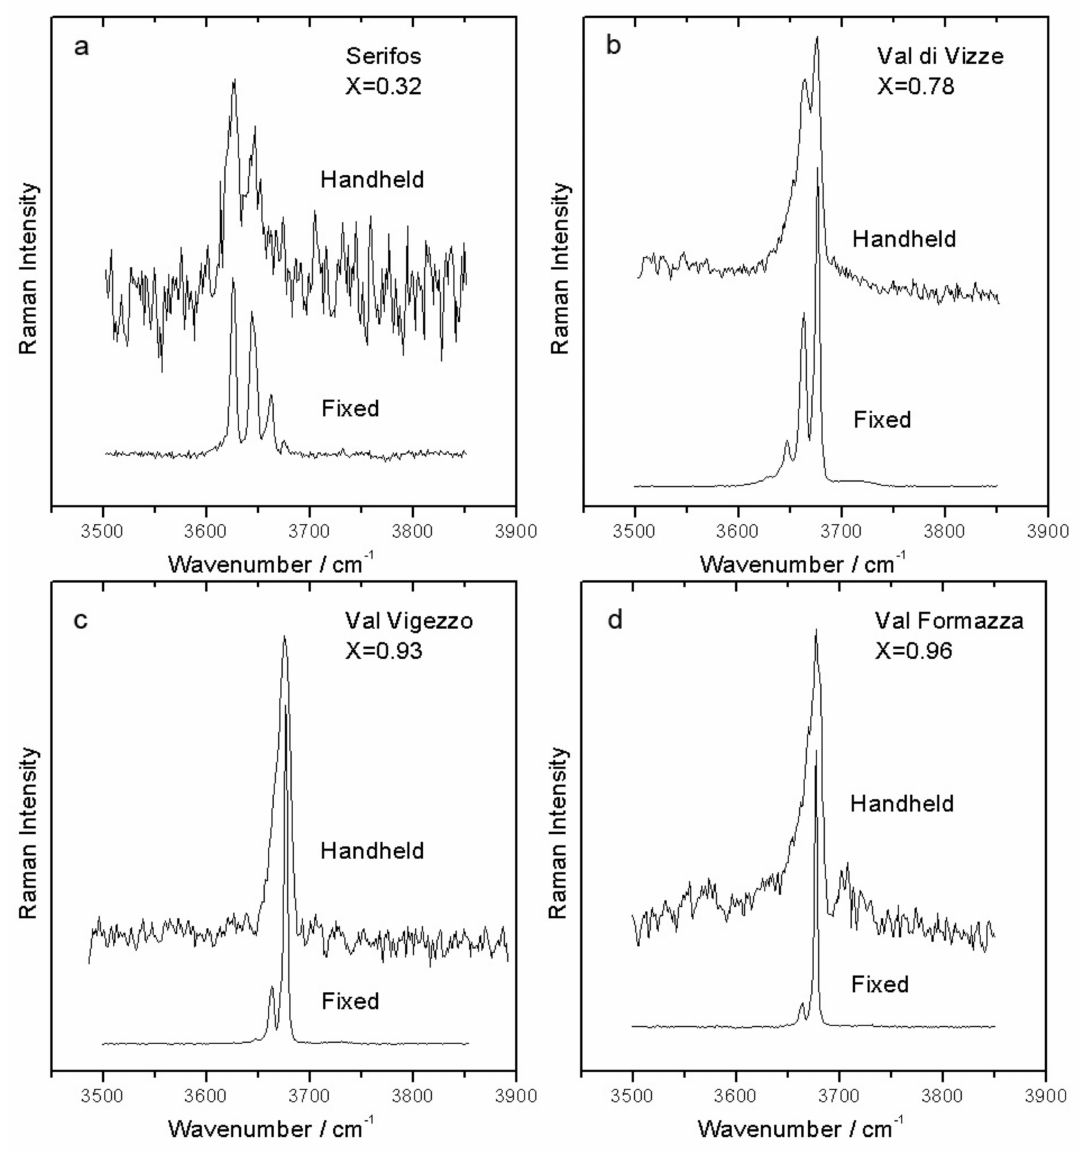
Figure 8. ( a – c ): comparison between spectra obtained on di ff erent samples in the OH-stretching region with fixed and handheld Raman spectrometers, ( d ): comparison between spectra obtained on Fe-rich and Fe-poor samples with the handheld spectrometer in the OH-stretching region. The X values reported in this figures are obtained by micro-Raman (fixed Raman)